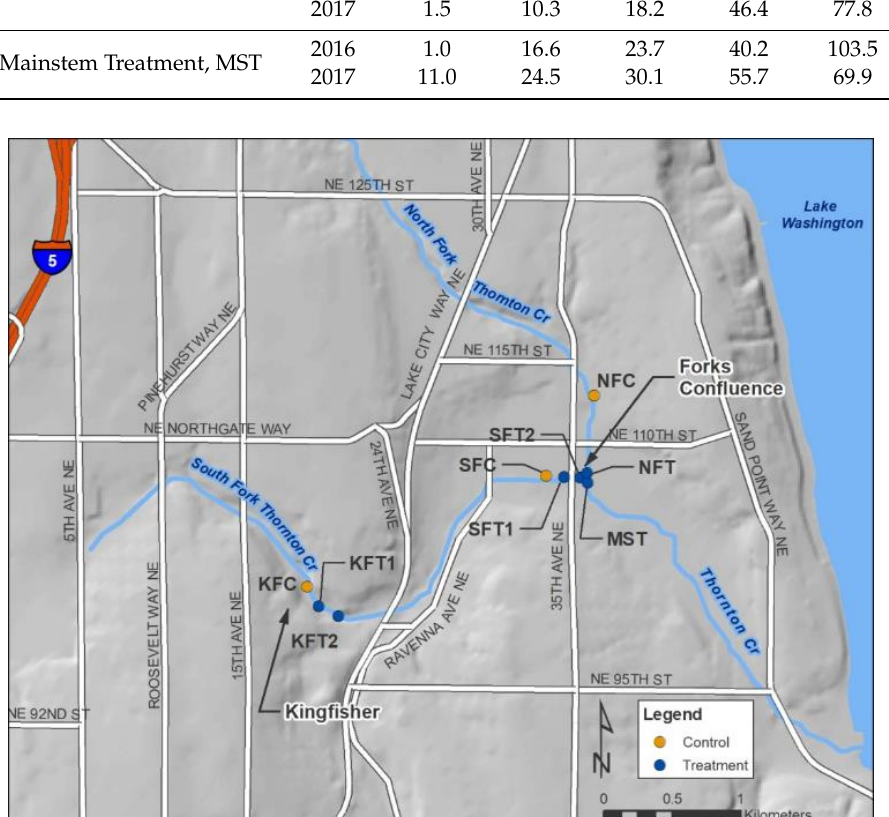
North Fork Control, NFC